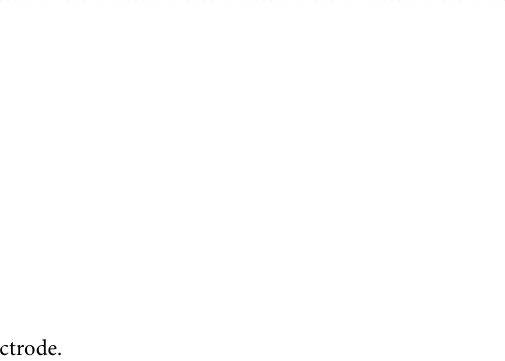
Figure 9. Net power gained calculated by the analytical model for the different systems studied. ( a ) Zinc cell. ( b ) Electrolysis cell.